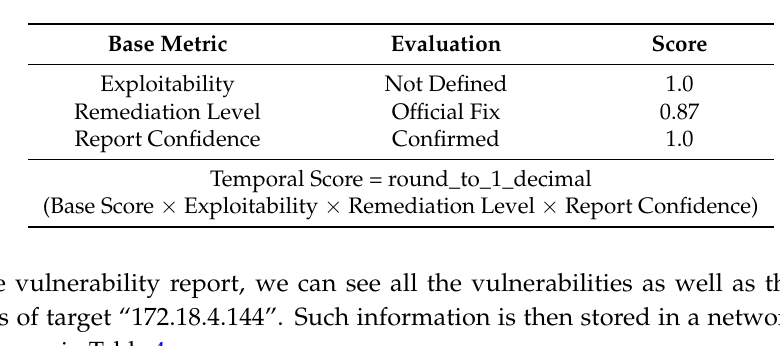
Table 3. CVSS Temporal Score.